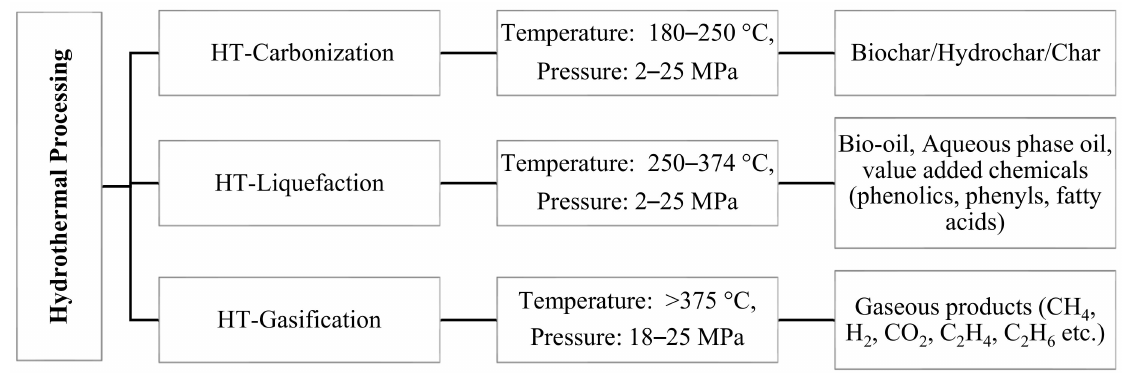
Figure 1. Different hydrothermal processing routes, reaction condition, and products (HT–hydrothermal)